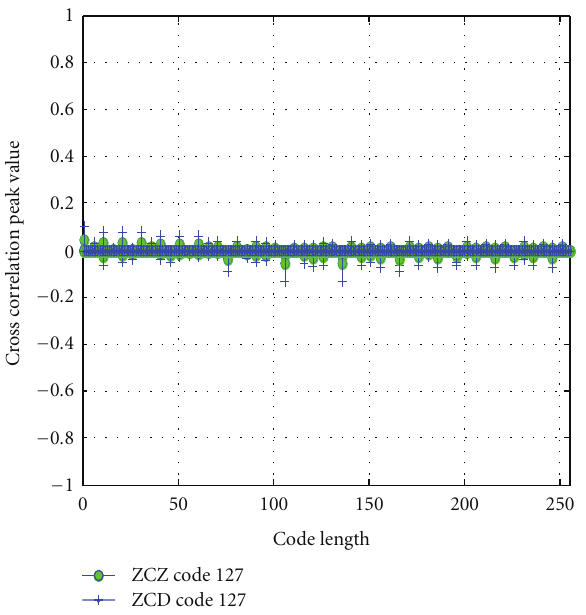
Figure 6: Performance of UWB system employing for varying modulation